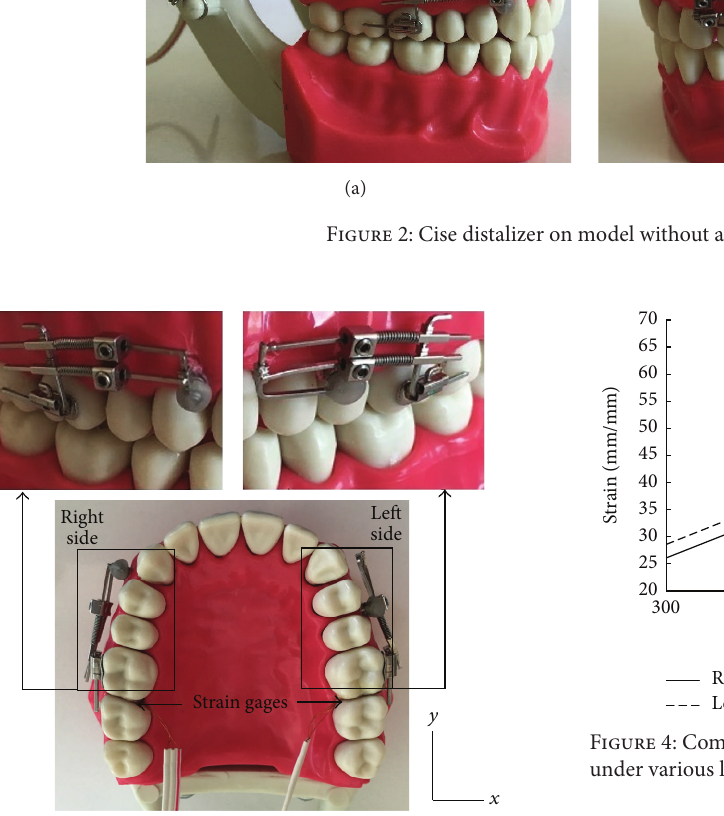
Figure 3: Cise distalizer and mounted strain gages on the model.